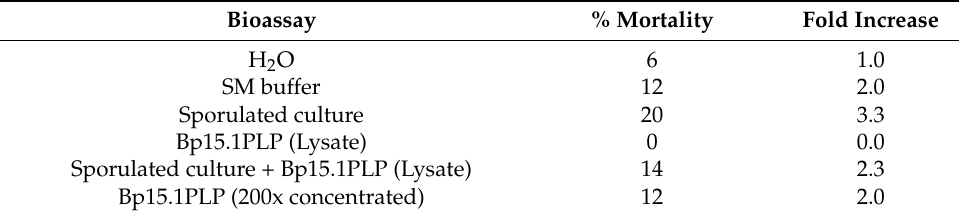
Table 8. Mortality results, obtained after 10 days in C. capitata larvae bioassays using sporulated cultures of B. pumilus 15.1 and different concentrations of Bp15.1PLPs. The increase in toxicity compared to the negative control (water) was also calculated (Fold increase